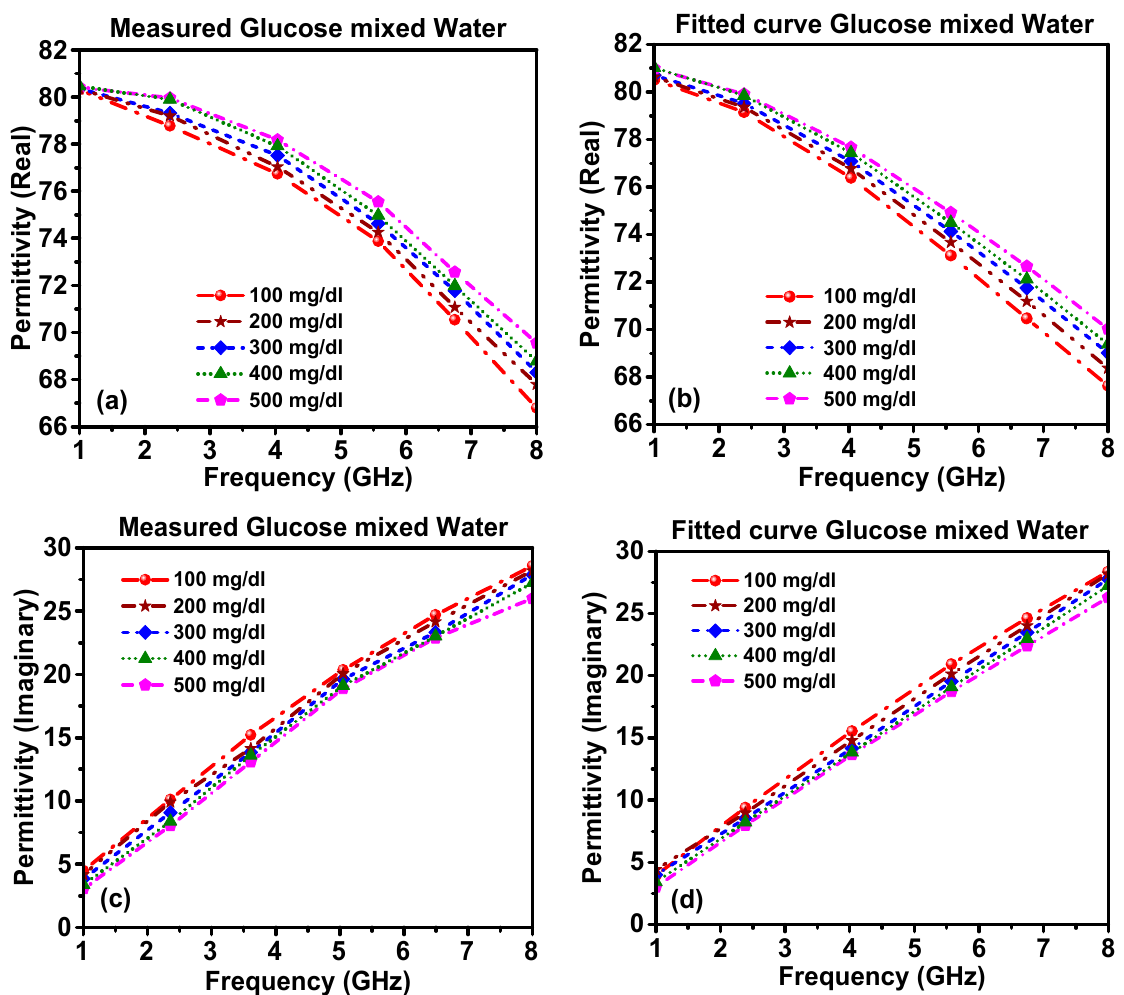
Figure 4. The complex permittivity of glucose–water mixture: ( a ) measured real part, ( b ) calculated real part, ( c ) measured imaginary part and ( d ) calculated imaginary part.